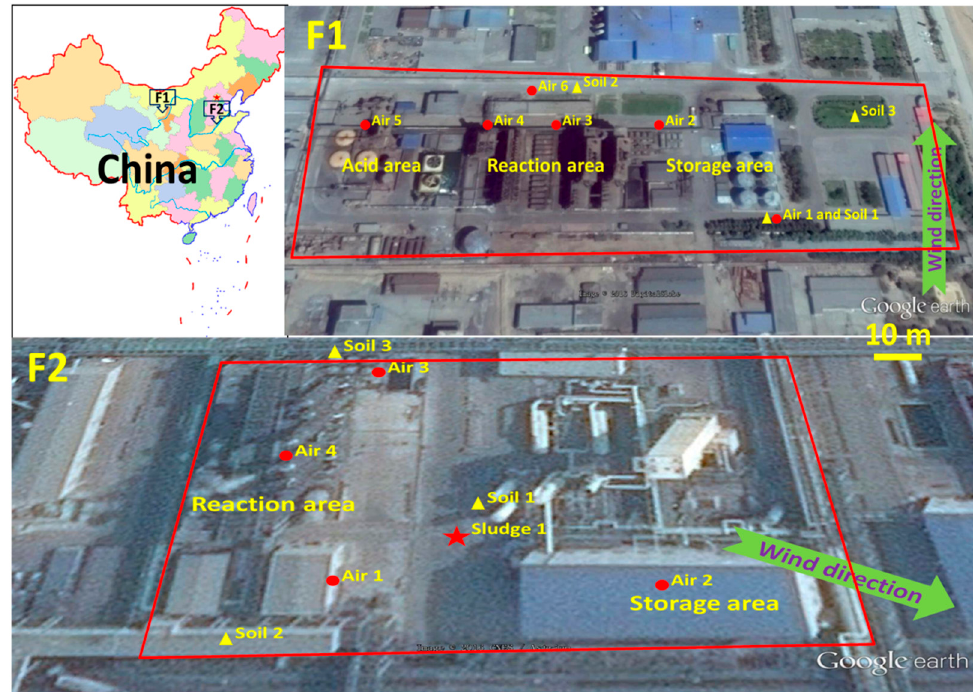
Figure 1. Map showing the air, soil, and sludge sampling sites in two tetrachloroethylene factories in China.